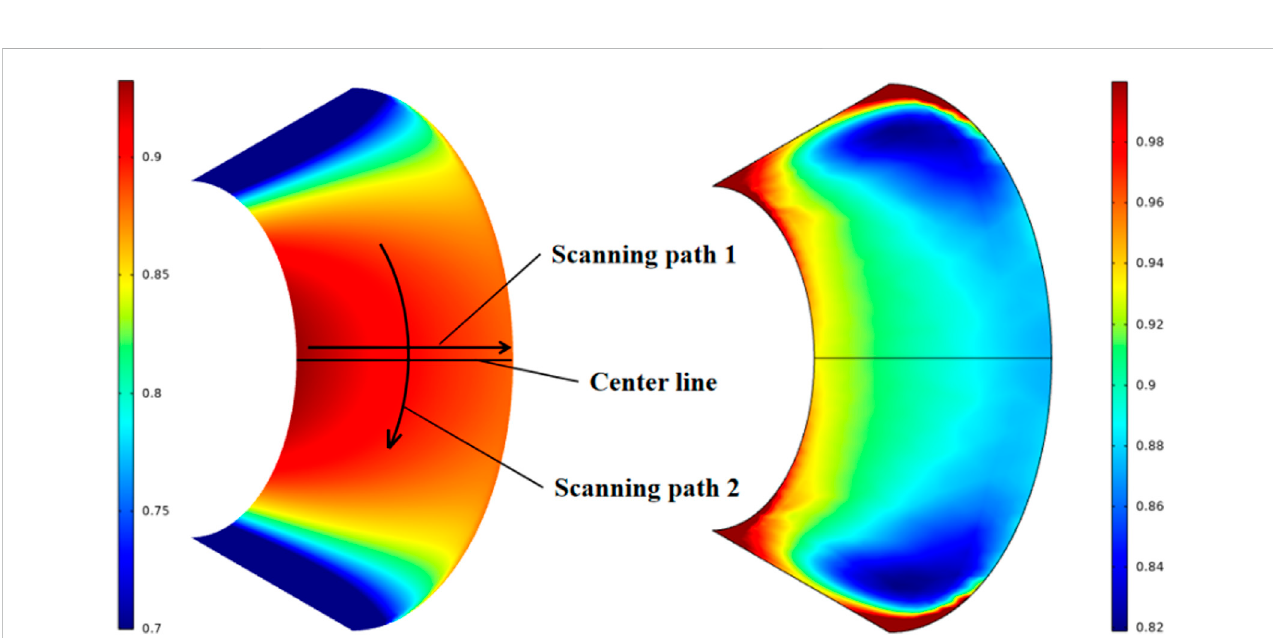
FIGURE 3 Cloud diagram of magnetic fi eld distribution of outer/inner bearing ring.